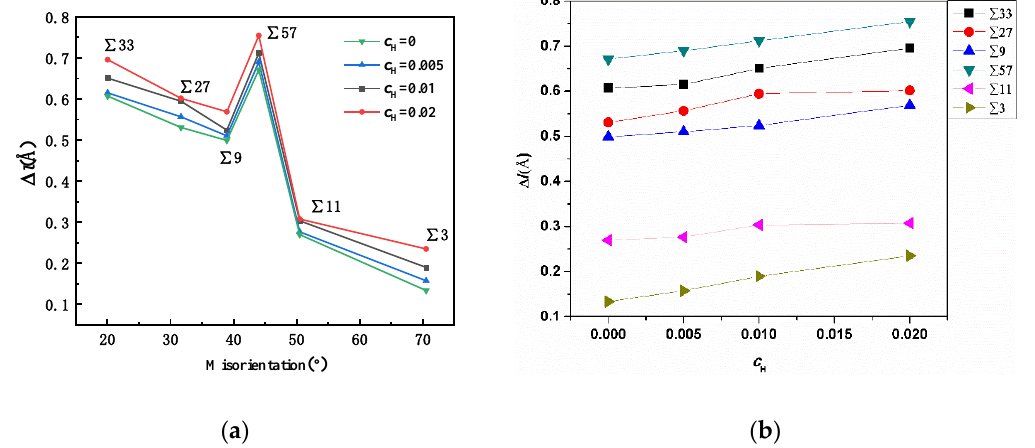
Figure 6. ( a ) Comparison of GB expansion at different hydrogen concentrations. ( b ) The hydrogen variation versus the excess volume change. The positive relation between the hydrogen concentration and the excess volume change is verified.